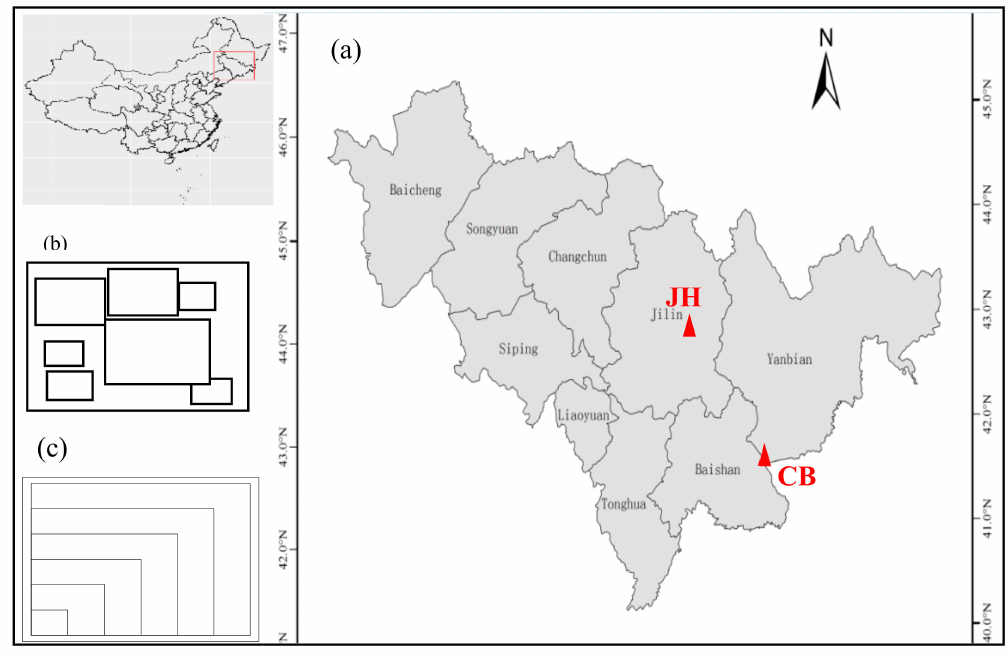
Figure 1. ( a ) The sampling plots (red triangles) of the broad-leaved Pinus koraiensis forests in Yanbian City in Jilin Province (CB), and the secondary coniferous and broad-leaved mixed forest in Eastern Jiaohe City in Jilin Province (JH), China, ( b ) and ( c ) random and nested sampling plots,